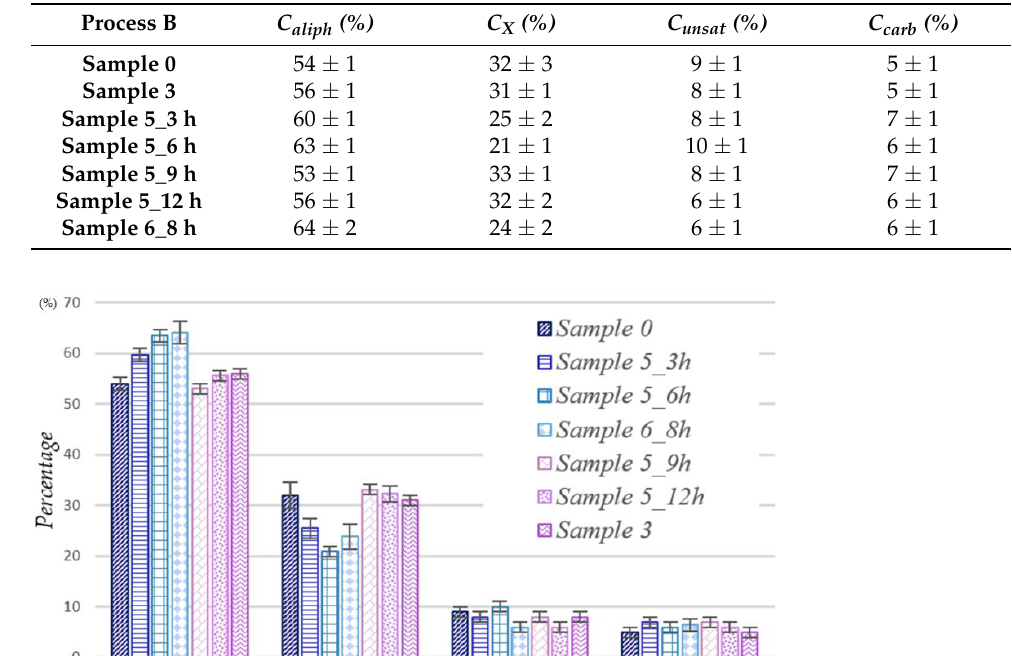
Table 4. Integral values, in percentage, of C aliph , C X , C unsat , and C carb , calculated for samples of process B and comparison with Sample 0 and Sample 3.